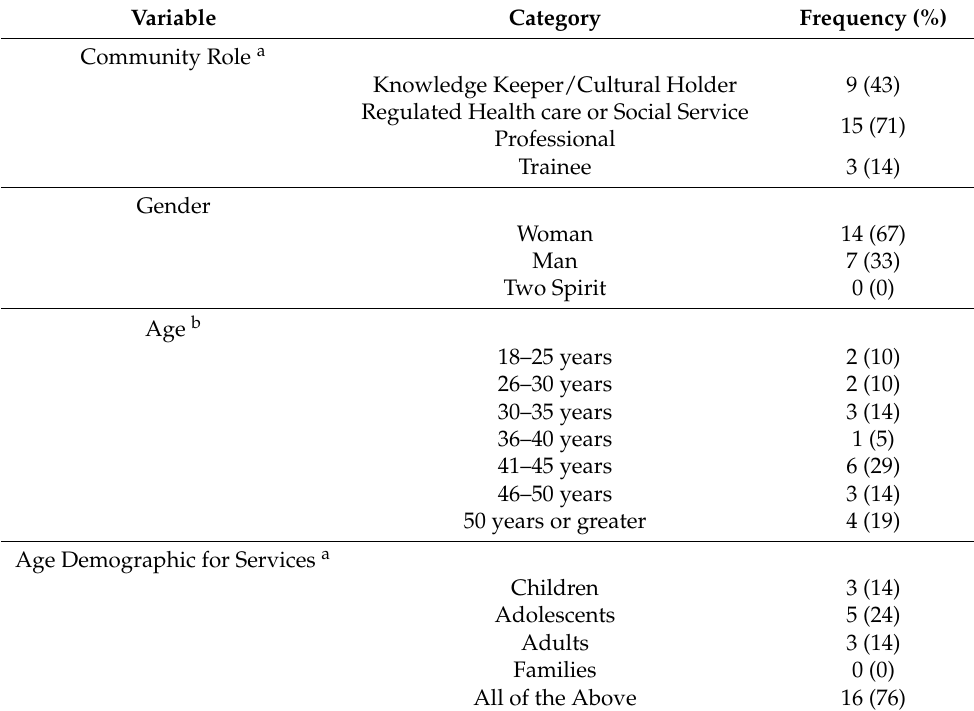
Table 2. Sociodemographic Characteristics of Research